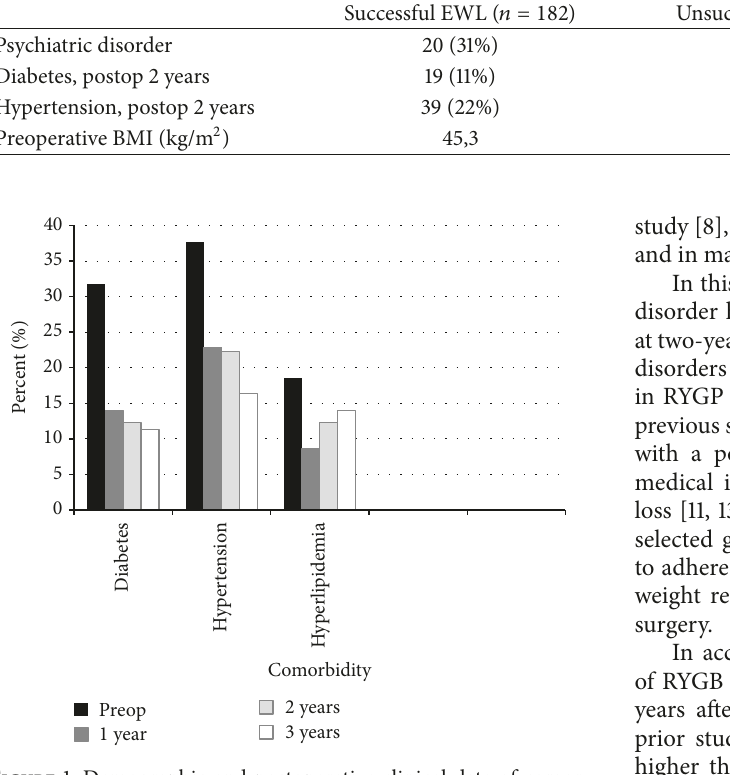
Figure 1: Demographic and postoperative clinical data of comor-